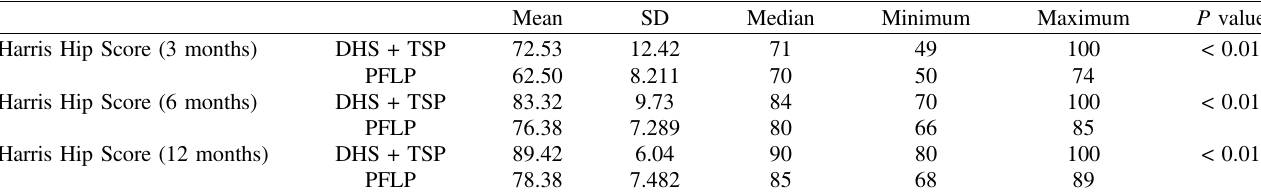
Table 1. Functional outcome per Harris Hip Score at 3, 6 and 12 months.